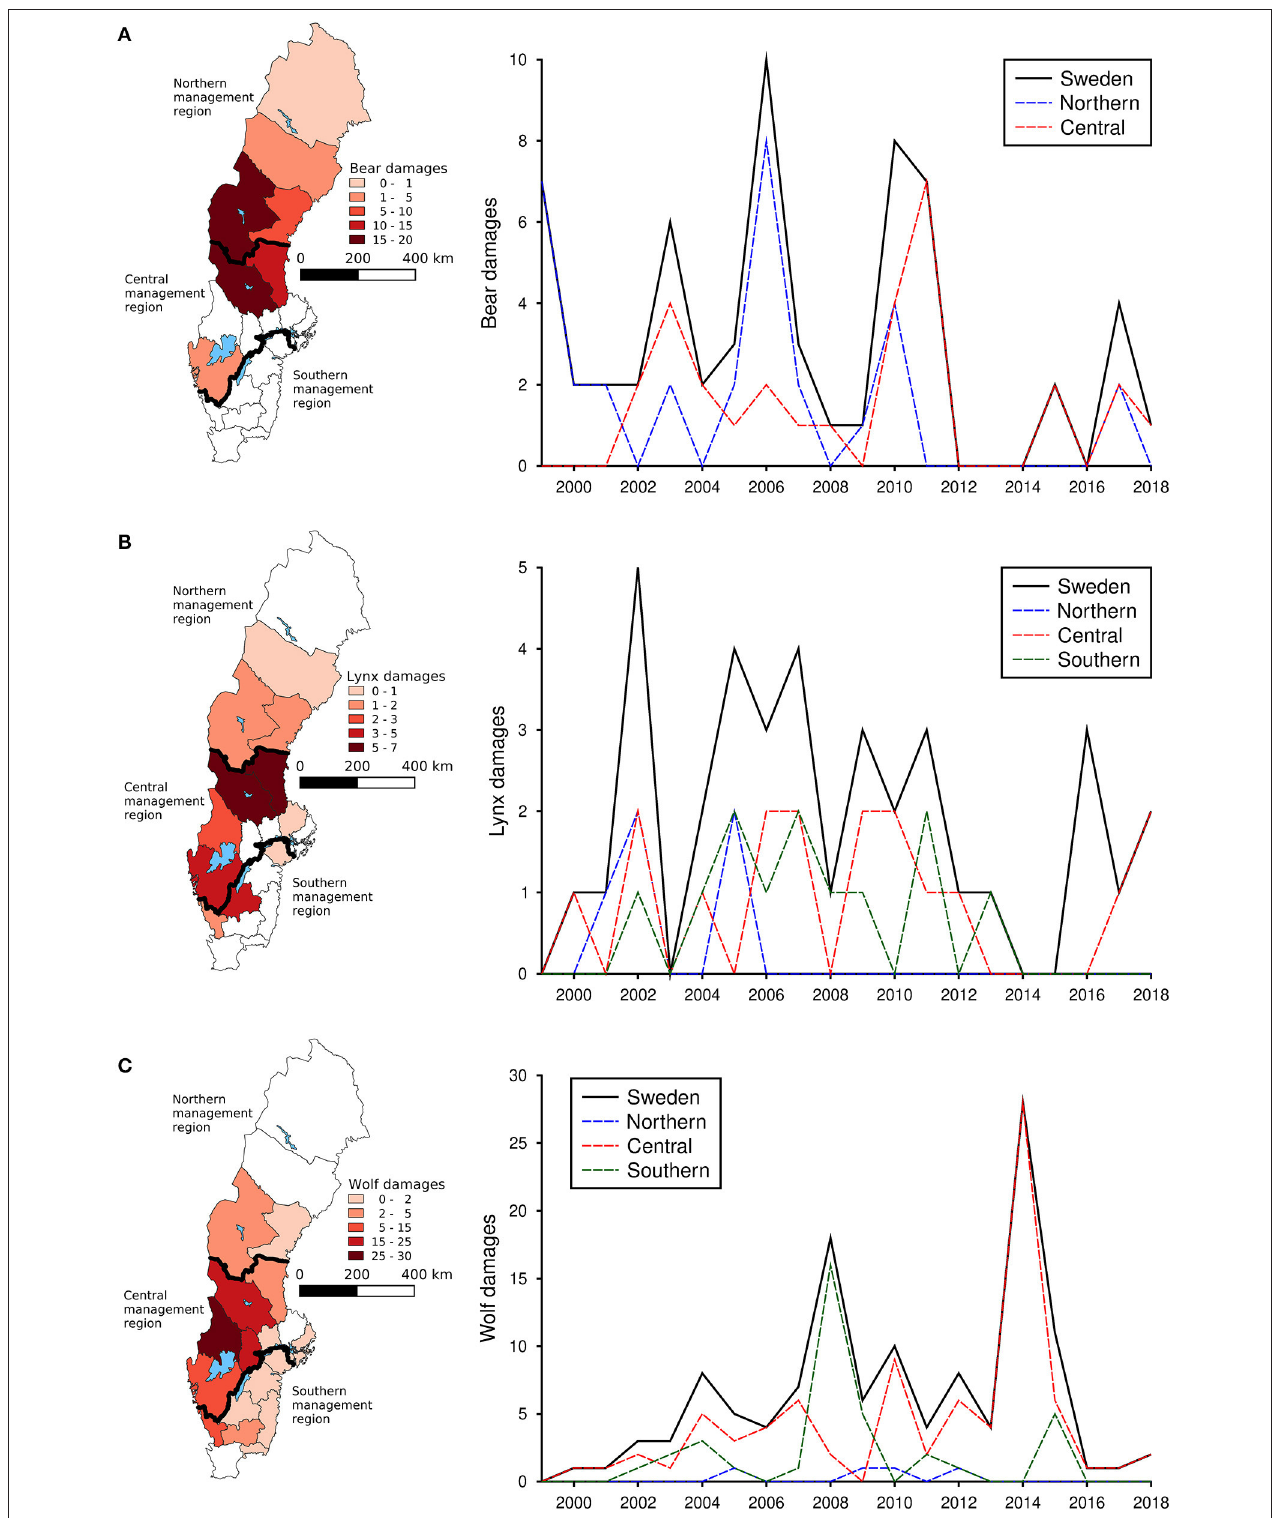
FIGURE 2 | Total number of damaged cattle by brown bear (A) , Eurasian lynx (B) , and gray wolf (C) in each county of Sweden from 1999 to 2018 as well as the national and regional trends for the same time period.